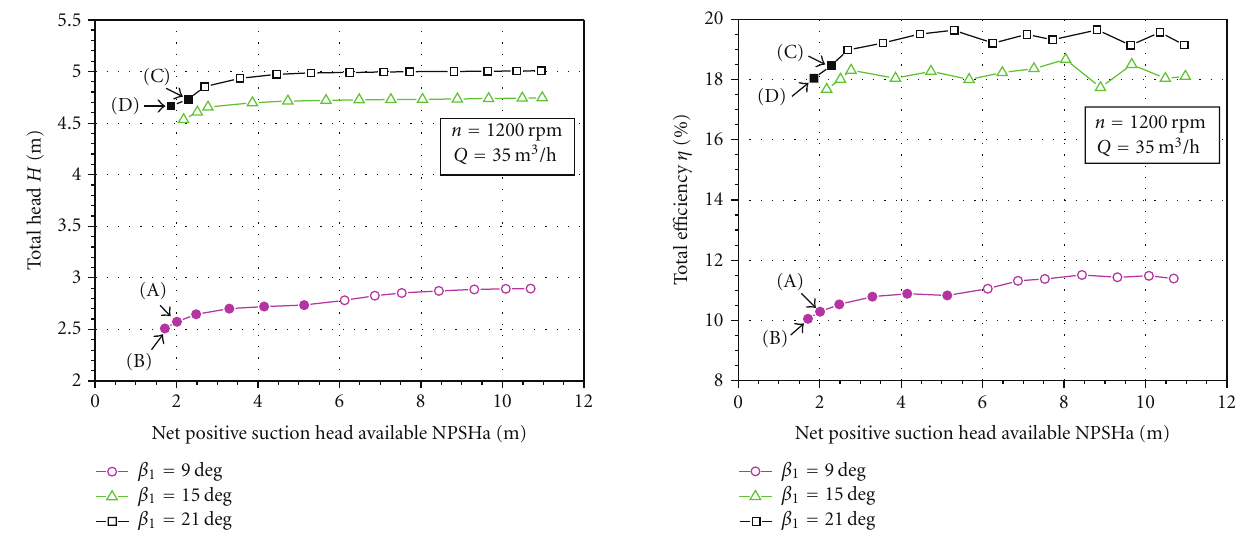
Figure 11: The change of the total e ffi ciency with the net positive suction head available for rotational speed of 1200 rpm and flow rate of 35 m 3